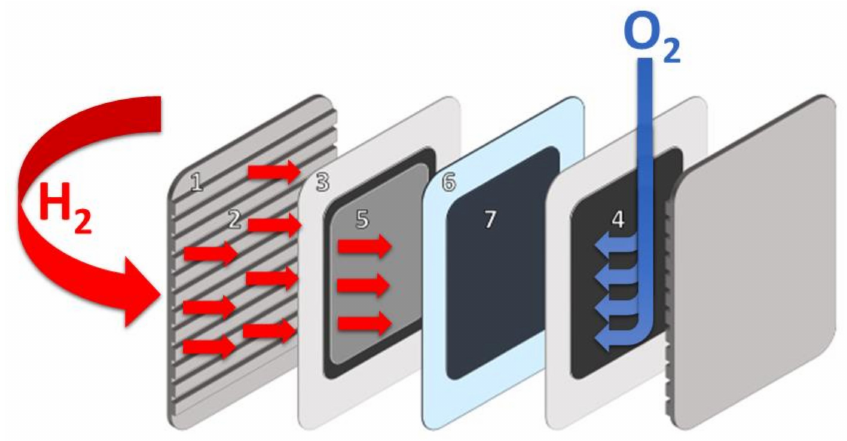
Figure 7. PEMFC structure: (1) bipolar plate; (2) flow channels; (3) sealing; (4) gas diffusion layer; (5) microporous layer; (6) electrolytic membrane; (7) catalyst layer (Reprinted with permission from Ref. [53], license No.